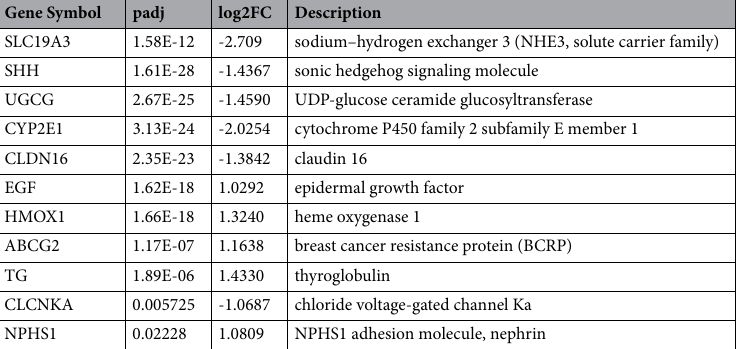
Gene Symbol padj log2FC Description SLC19A3 1.58E-12